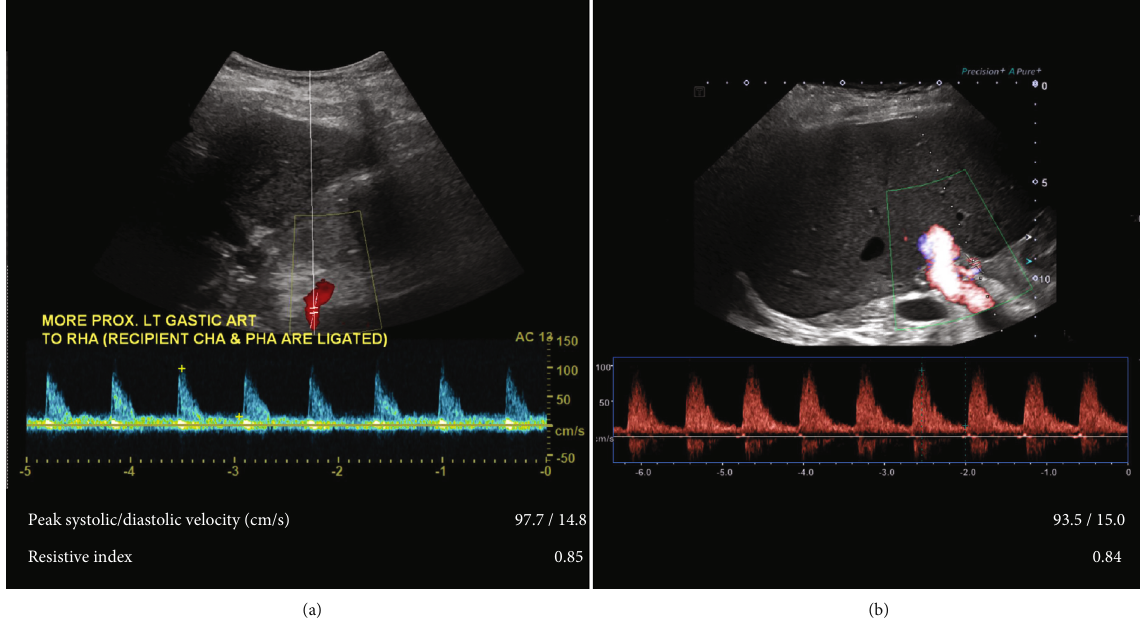
Figure 4: Case 2 Doppler ultrasound (US) imaging on postoperative day 1 with appropriate waveforms at the alternatively reconstructed anastomosis with in fl ow from the left gastric artery (a). Repeat US nine-month posttransplant with stable fi ndings